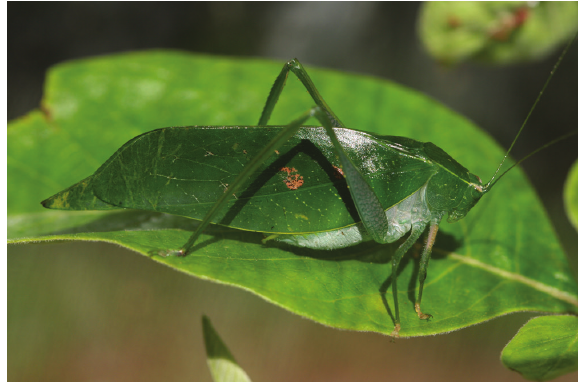
Figure 14. Gonatoxia immaculata male, East Usambara Moun- tains. Note the orange patches on the tegmina and the deep green shiny colour.